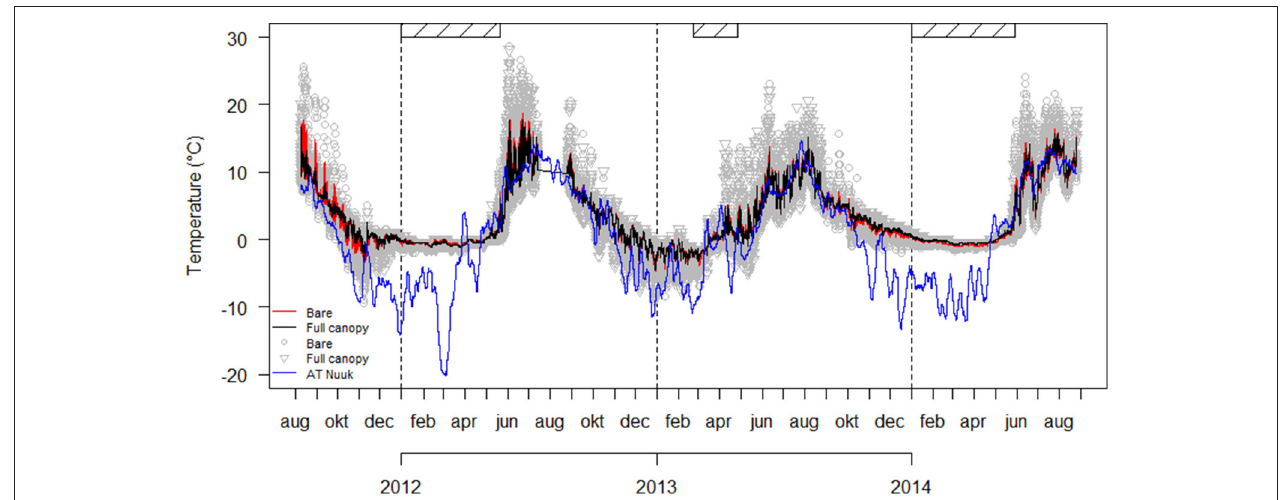
FIGURE 4 | Temperature with running mean (10 observations) recorded in mid intertidal at inner Kobbefjord for the two treatments “Full canopy” and “Bare (start)” from August 2011 through August 2014 (data not available for July 14th–Aug 24th 2012). Air temperature (AT) with running mean (336 observations) recorded in Nuuk by the Greenland Ecosystem Monitoring program in the same period. Hatched bars represent periods of sea ice cover in inner Kobbefjord based on automatized photographing (data only available for January through May).